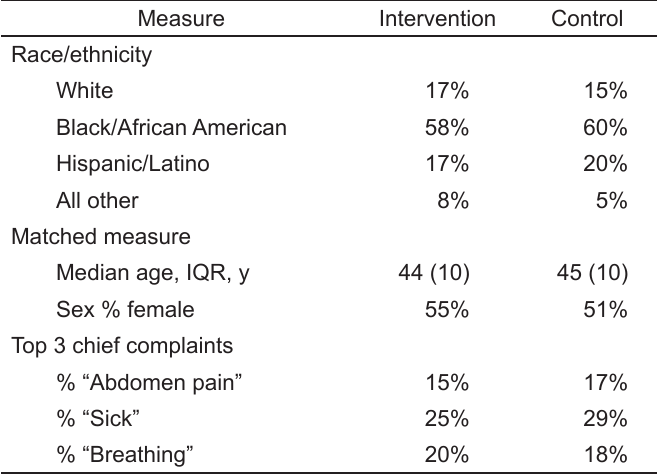
Table 1. Descriptive characteristics of intervention patients and control group in a study comparing the effectiveness of an alternative EMS telehealth delivery model relative to traditional EMS care.